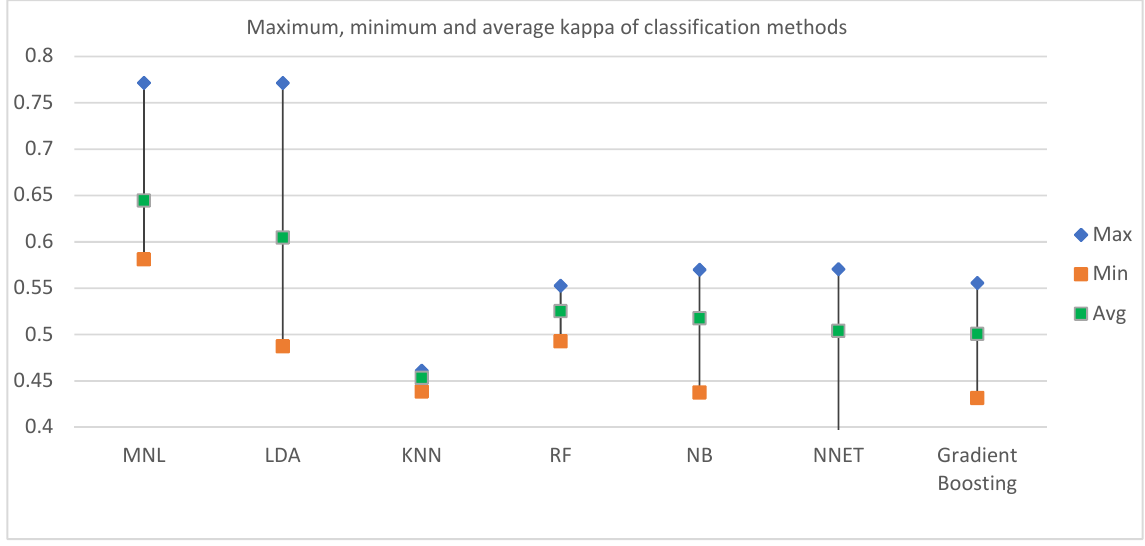
Figure 4. Maximum, minimum, and average kappa of classification methods.